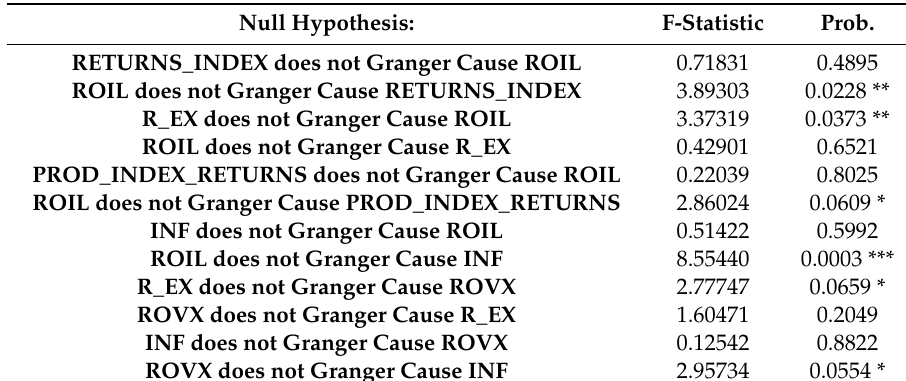
Table 8. Granger causality.